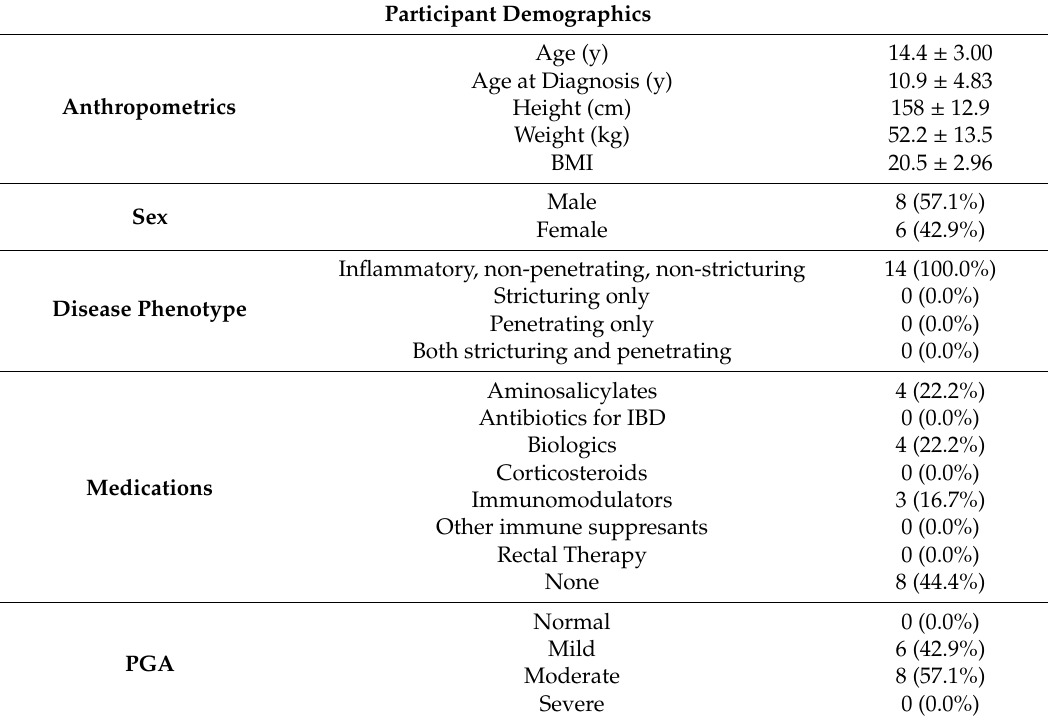
Table 1. Reporting demographic variables of 10 patients in the